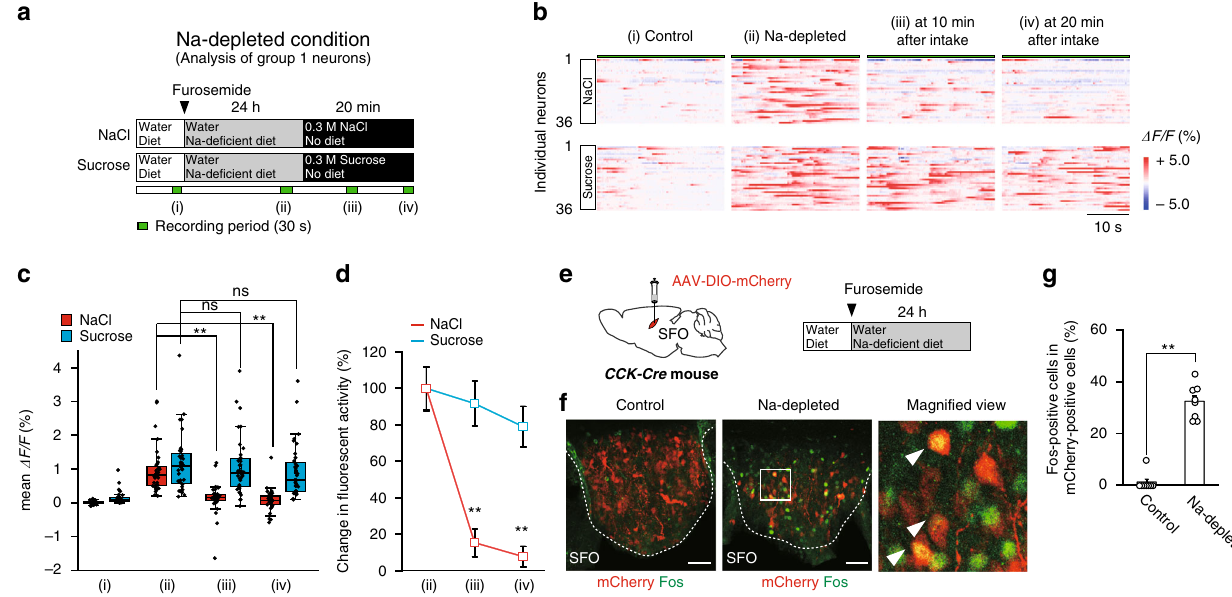
Fig. 5 The activity of group 1 CCK-positive neurons in the SFO under the Na-depleted condition is attenuated by salt intake, but not fl uid intake. a Experimental protocols for Ca 2 + imaging of group 1 CCK-positive neurons in the CCK-Cre mouse during 0.3 M NaCl or 0.3 M sucrose drinking under the Na-depleted condition. A large proportion of the intake of both fl uids ceased within 20 min. b Raster plots of calcium responses in individual group 1 CCK- positive neurons under each sequential condition ( n = 36 neurons in two mice). c Dot plot of calcium responses in individual CCK-positive neurons during 30 s at four temporal positions in ( b ). n = 36 neurons in two mice. ns, not signi fi cant; ** P < 0.01; two-sided one-way RM ANOVA (NaCl, F(3,33) = 24.80, P = 1.38 × 10 − 8 ; sucrose F(3,33) = 33.87, P = 3.47 × 10 − 10 ), with post hoc two-sided paired Student ’ s t -tests (NaCl, P = 9.84 × 10 − 7 , (ii vs iii) P = 9.21 × 10 − 9 ; sucrose, P = 0.571, P = 0.196). Box-plot elements (center line, upper and lower box limits, whiskers, and points) were (ii vs iv) (ii vs iii) (ii vs iv) de fi ned as medians, quartiles, 1.5× interquartile ranges, and outliers. d Changes in calcium responses from those under the Na-depleted condition. ** P < 0.01; two-sided paired Student ’ s t -tests ( P (iii) = 3.47 × 10 − 8 ; P (iv) = 3.24 × 10 − 8 ). e Left: Injection of AAV-DIO-mCherry into the SFO of the CCK-Cre mouse. Right: Experimental protocol for the induction of the Na-depleted condition. f Immunohistochemical staining of mCherry and Fos in the SFO under the control and Na-depleted conditions. Arrowheads indicate double-positive cells under the Na-depleted condition. These images were reproduced from more than three independent mice. Scale bar, 50 µ m. g Ratio of Fos-positive cells to mCherry-positive cells in the SFO ( n = 8 sections each). ** P < 0.01,